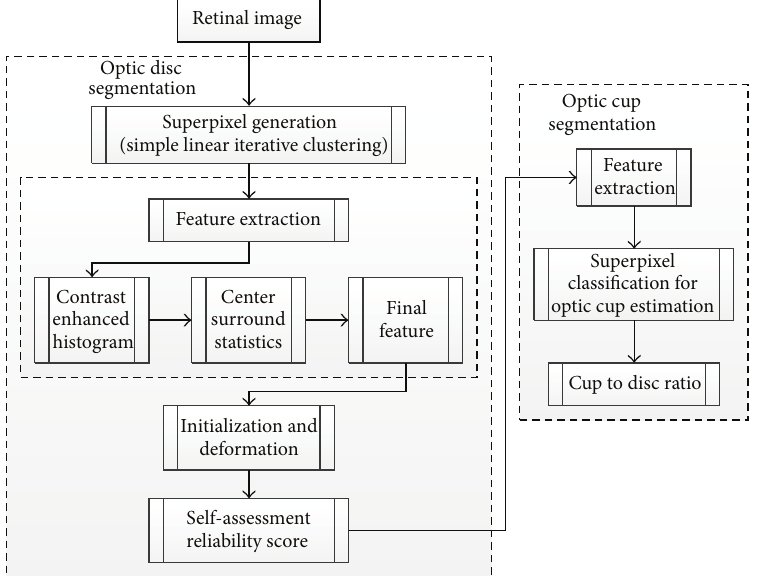
Figure 30: Flowchart for algorithm proposed in